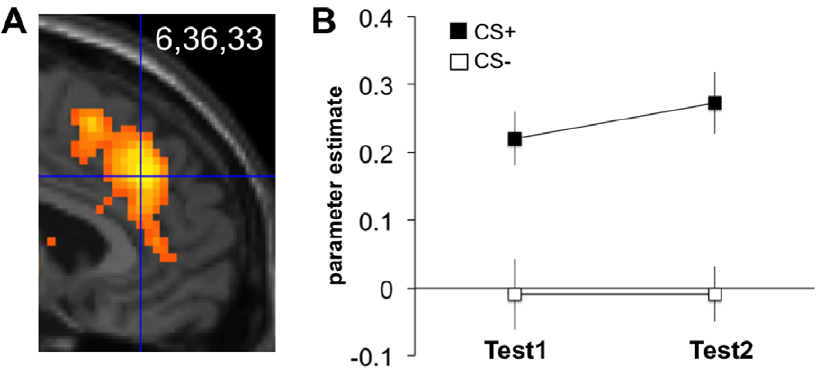
Figure 2. Instructed fear (study 1): Rostral dmPFC/dACC activation. ( A ) Contrast ‘CS + . CS 2 ’ across both test runs (IF-Test1, IF-Test2) (model 1, see Methods ). Display threshold: p , 0.001 uncorrected. Activations superimposed on a canonical structural image. ( B ) Parameter estimates from the peak voxel, estimated separately for each test run (model 2). Error bars: s.e.m.